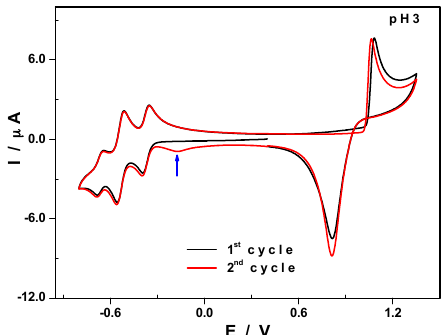
Figure 5. CVs of 1 in 0.5 M Li 2 SO 4 + H 2 SO 4 /pH 3. Polyoxometalate concentration: 0.5 mM; scan rate: 10 mV · s − 1 ; working electrode: glassy carbon; reference electrode: SCE. Potentials were initially scanned down to − 0.8 V (reduction region) then up to +1.35 V (oxidation region); the first cycle is in black and the second in red.